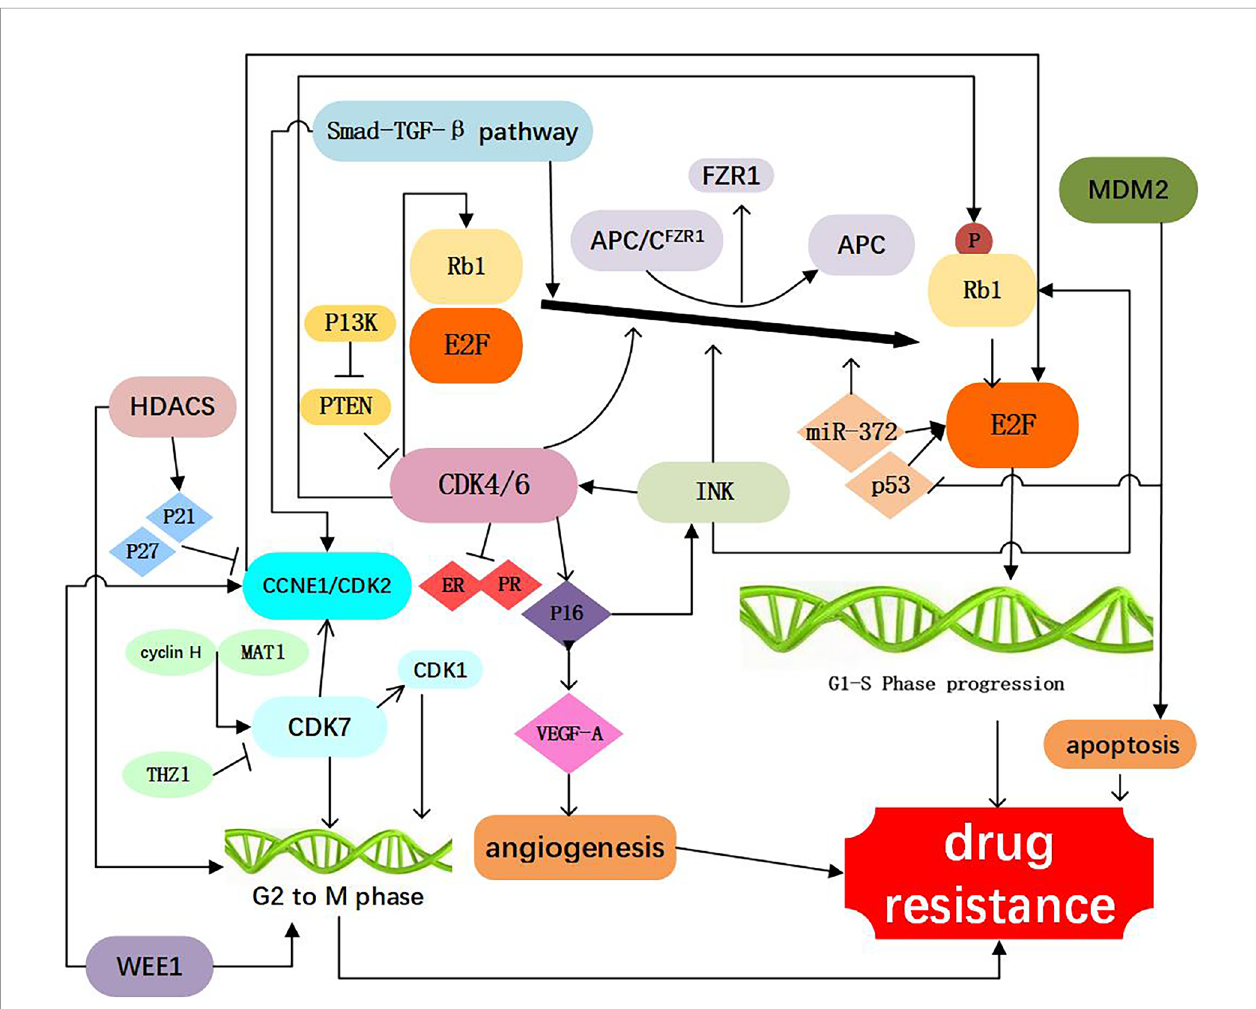
FIGURE 2 | Resistance to CDK4/6 inhibitors: Direct Cell Cycle Mechanism: 1. Loss of drug target genes: APC/CFZR1 promote the phosphorylation of Rb1 and regulate cell transition from G1 to S. knockdown of Rb1 and FZR1 synergistically bypassed cell division arrest induced by the CDK4/6 inhibitor (14 – 23); 2. Increased activity of the CDK4 and CDK6: ampli fi cation of CDK4/6 account for a decreased CDK4/6 targeted phosphorylation of Rb1 and a decreased sensitivity of breast cancer cells to CDK4/6 inhibitor (2, 24 – 34); 3. Abnormal regulations of upstream and Downstream kinases: CCNE1/CDK2, CDK7, E2F, INK, PTEN, Smad-TGF- b pathway which are involved in the progression of cell cycle, as shown in Figure 1 , are responsible for resistance to CDK4/6 inhibitors (12, 15, 17, 26, 35 – 60); 4. Activation of alternate genes like HDACS, WEE1, MDM2, partly help the cancer cell escape from the drugs work (61 –